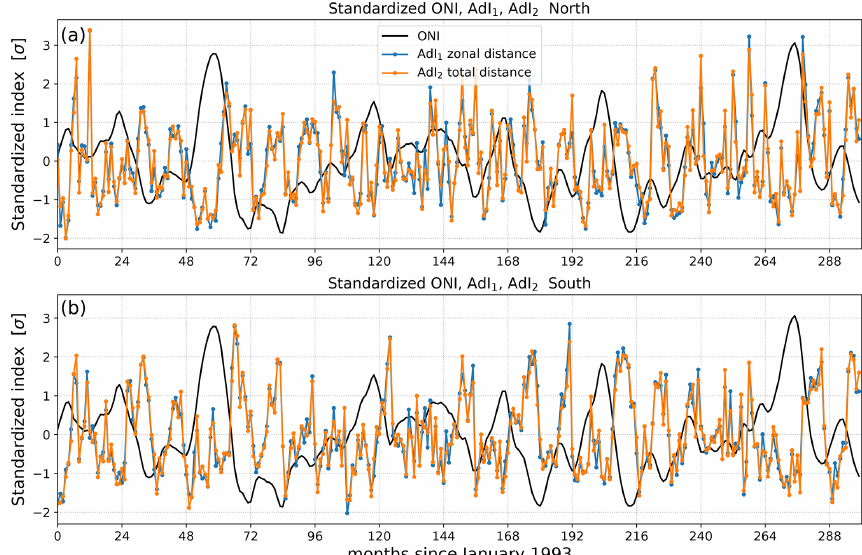
Figure 2. Standardized advection indices AdI 1 and AdI 2 determined as ensemble averages of the monthly westward displacements. The first is based on the monthly zonal distance from the position at the end of the previous month; the second is the total trajectory length in a month (meridional components are also taken into account). For a comparison of variabilities, the ONI (Oceanic Niño Index) is also plotted as black lines. (a) northern section; (b) southern section.